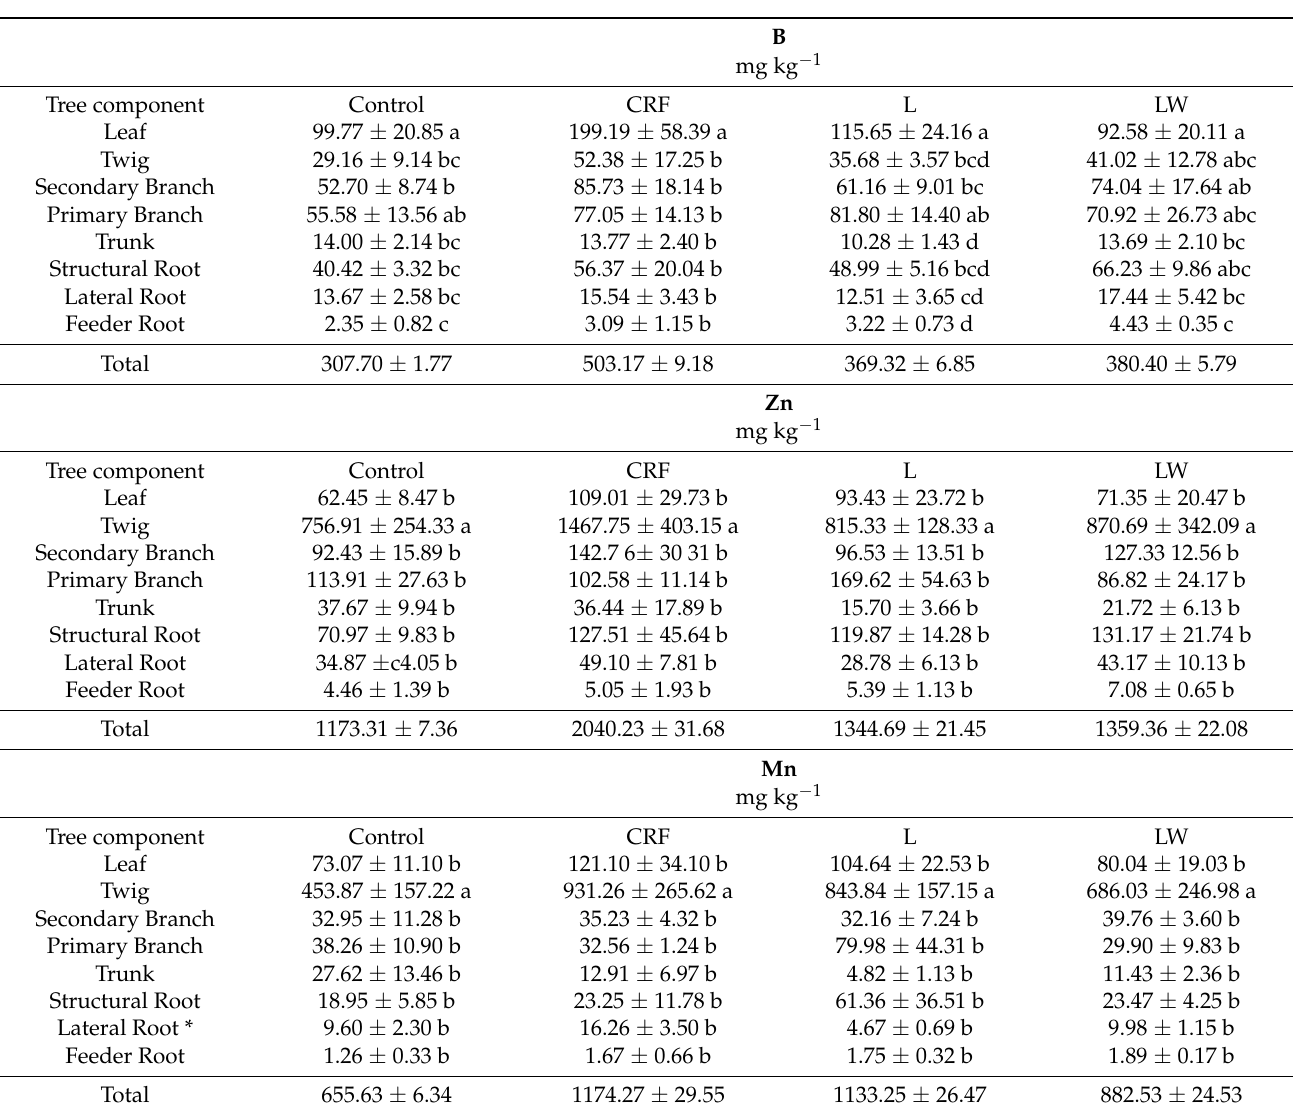
Table 3. Boron (B), zinc (Zn), and manganese (Mn) contents per individual components and tree total. Six-year-old Huanglongbing-affected ‘Ruby Red’ grapefruit trees grafted on sour orange rootstock were used. Treatments consisted of two liquid (L and LW) and two granular fertilizers (Control and controlled-release fertilizer (CRF)). A Kruskal–Wallis test was used in combination with a Tukey’s honestly significant difference (HSD)test to identify and test significant differences in total nutrients in individual tree components (differences signified by letters). A one-way analysis of variance (ANOVA) with a Tukey HSD test was used to determine significant differences between the means of between different fertilizer application methods (differences signified by *). Data represents means ( n = 4) ± standard